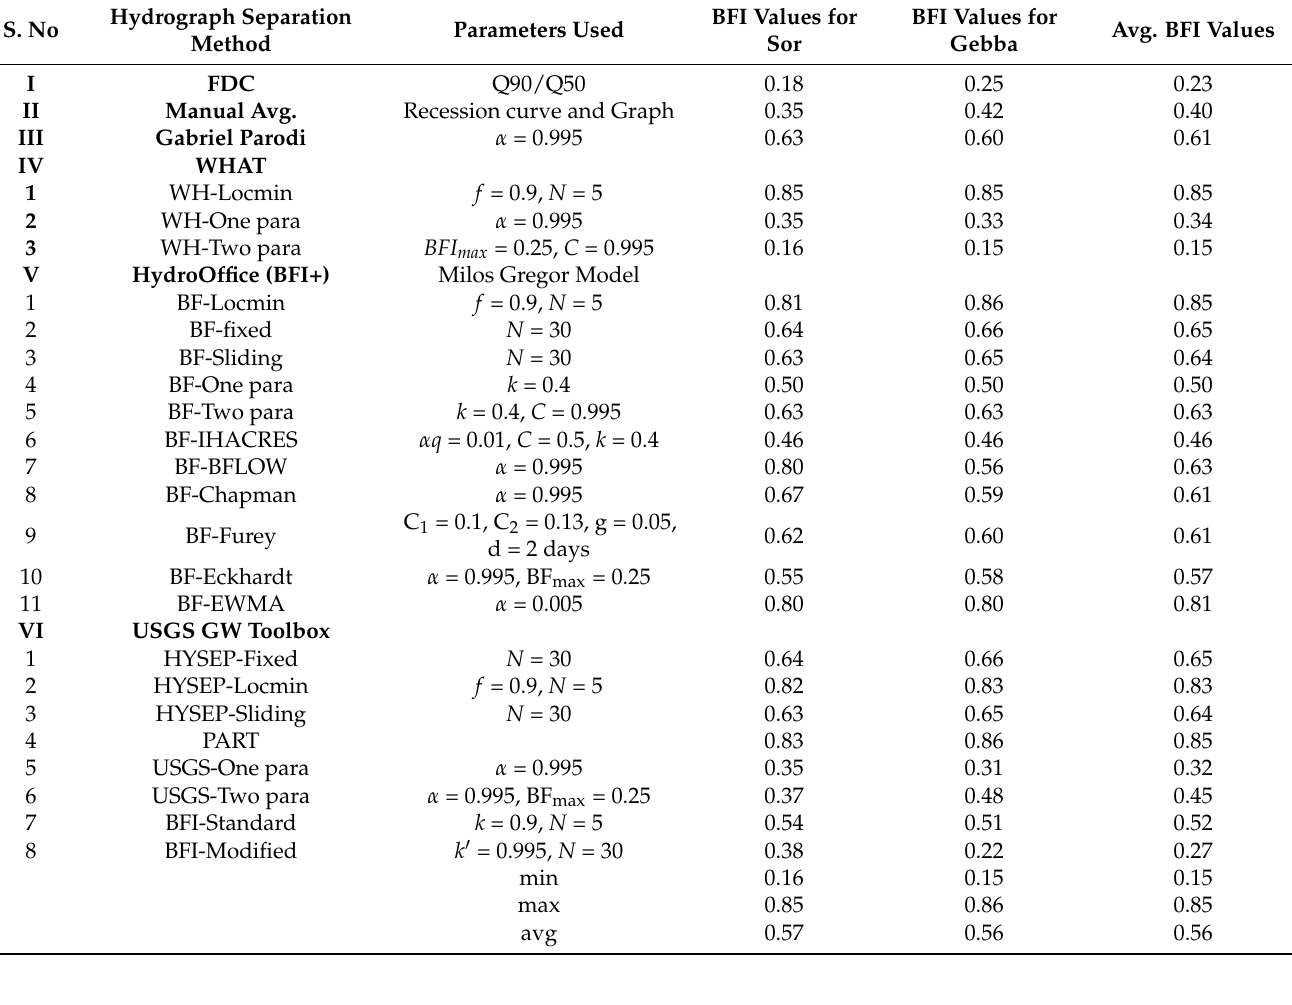
Table 6. Summary of used parameters and BFI values from all baseflow separation techniques.